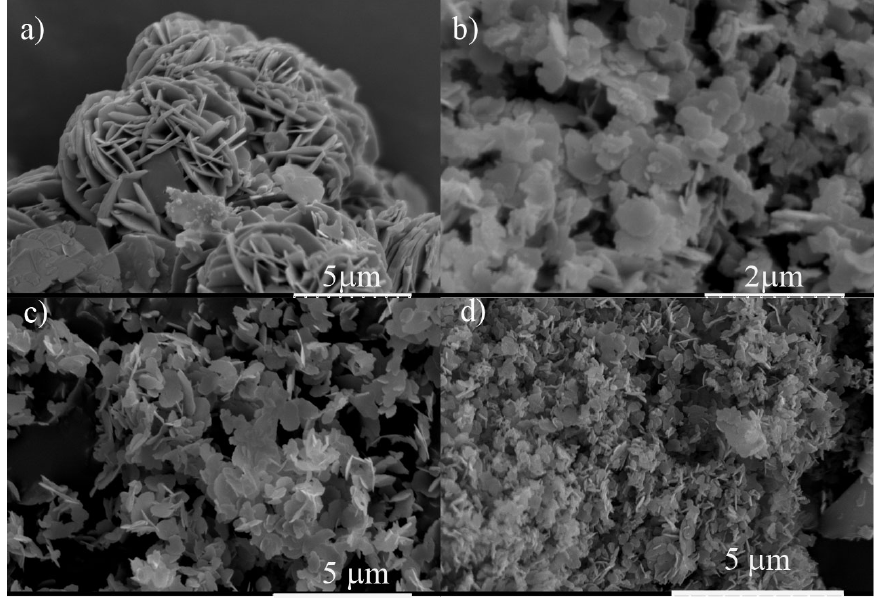
Figure 8. Scanning electron micrographs of activated catalysts from precursors prepared in ( a ) traditional synthetic route, atmospheric drying; ( b ) alkoxide method, autoclave drying, low solvent; ( c ) alkoxide method, autoclave drying, medium solvent and ( d ) alkoxide method, autoclave drying, high